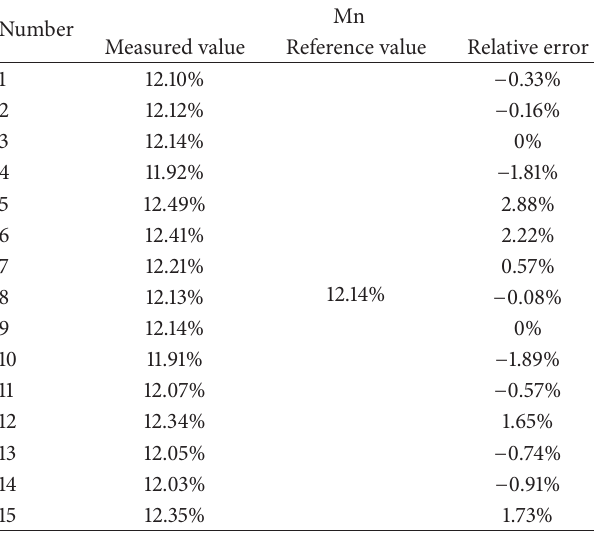
Table 4: Mn content of high-Mn